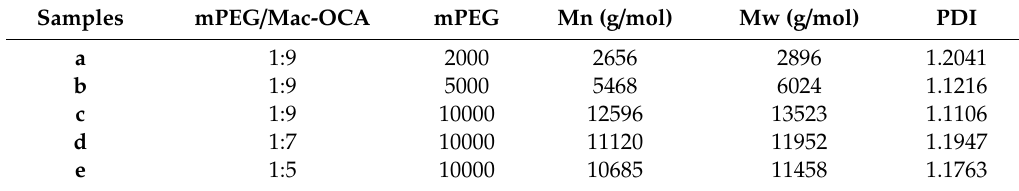
Table 1. Distribution of the number-average molecular weight (Mn), the weight-average molecular weight (Mw) and polydispersity index of the molecular weight distribution (PDI)of mPEG-PMA Polymer.